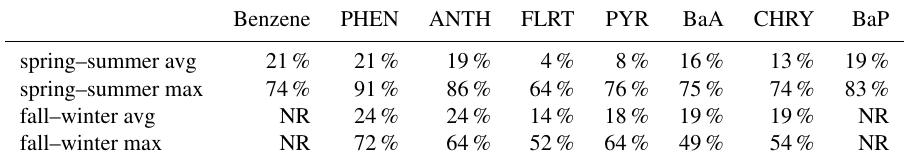
Table 1. Domain-wide average and maxima on-road vehicle contribution to ambient concentrations. “NR” represents not reported. Benzene PHEN ANTH FLRT PYR BaA CHRY